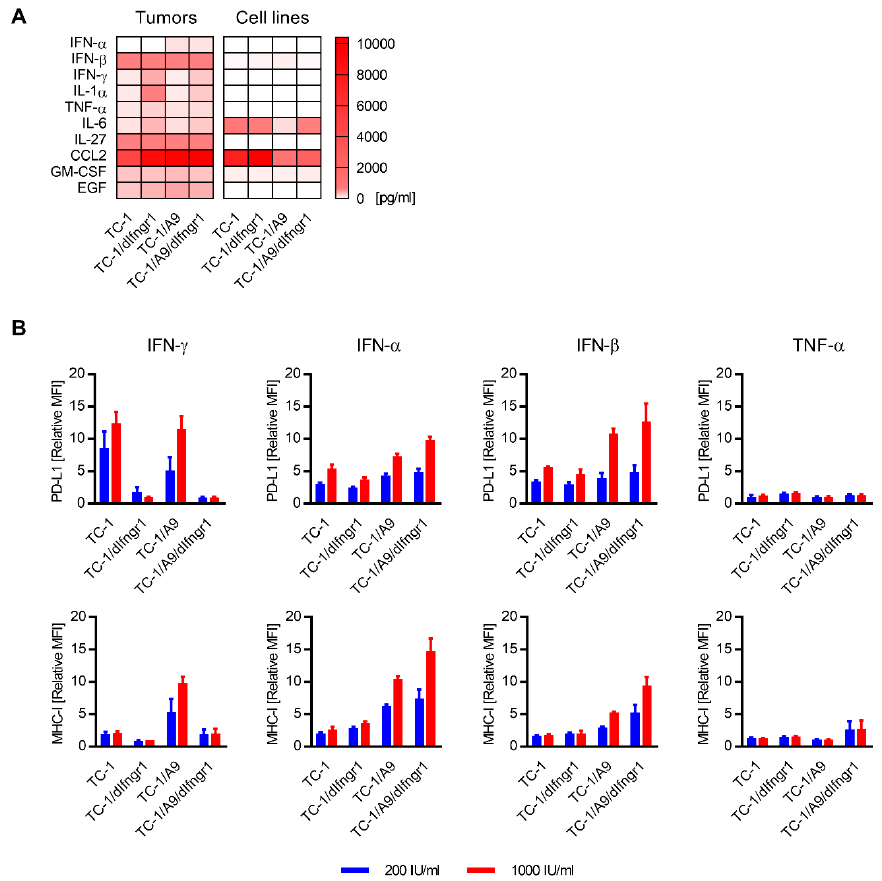
Figure 4: The effect of cytokines on PD-L1 and MHC-I surface expression. ( A ) The quantification of cytokines that can enhance PD-L1 and/or MHC-I expression in tumors and supernatants of cells cultured in vitro. ( B ) The effect of IFN- γ , IFN- α , IFN- β , or TNF- α on PD-L1 and MHC-I expression in vitro. Median fluorescence intensity, MFI. Relative MFI was calculated as MFI stimulated cells /MFI unstimulated cells . Columns, means of three samples; bars, ± SEM.